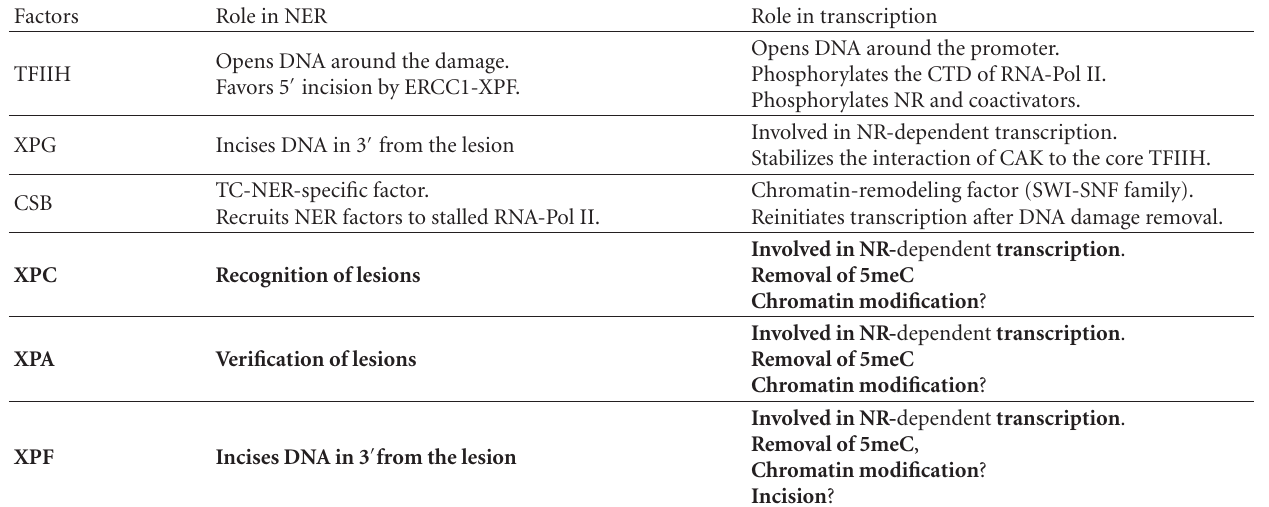
Table 1: Repair/transcription factors and their